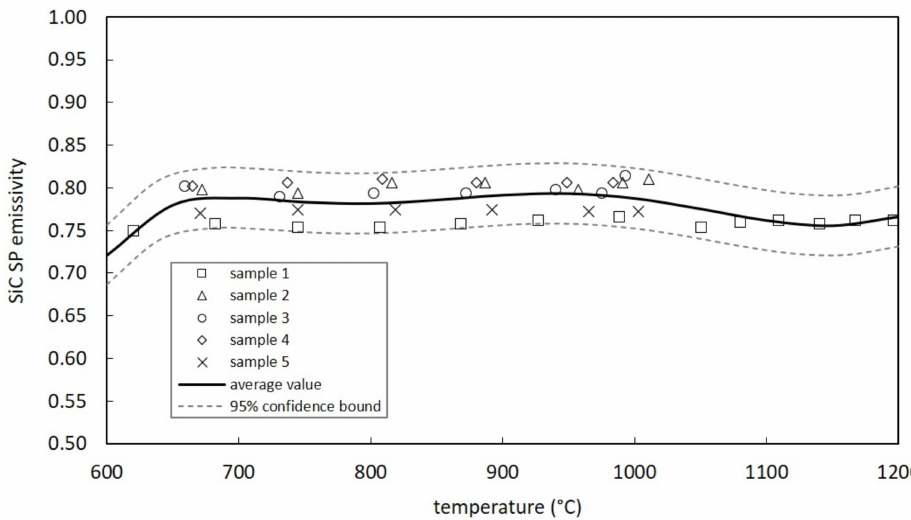
Figure 10. Measured emissivity values for SiC SP